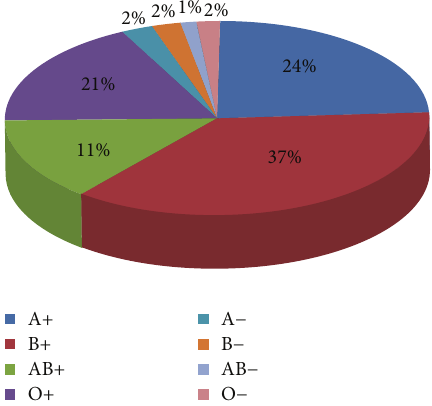
Figure 1: Blood groups of patients.